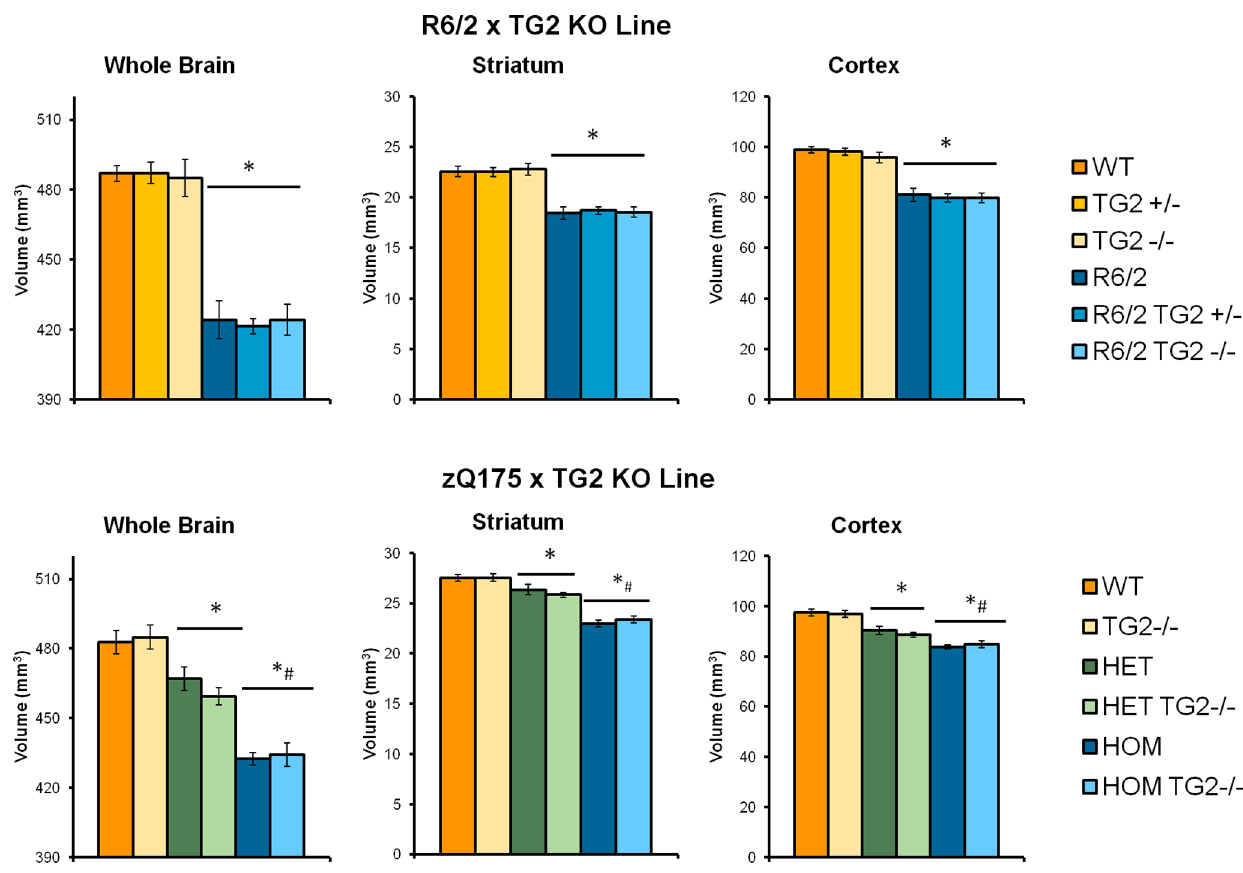
Figure 14. Whole brain, striatal and cortical volumes of 16-week-old R6/2 6 TG2 KO mice (top panels, n=6 per genotype per sex) and of 52-weeks-old zQ175 6 TG2 KO mice (bottom panels, n=6 per genotype per sex). *Significant differences compared to WT animals, # significant differences compared to HET mice. WT: wild-type, TG2 + / 2 : heterozygous TG2 knockout, TG2 2 / 2 : homozygous TG2 knockout, HET: zQ175 HET, HOM; zQ175HOM.